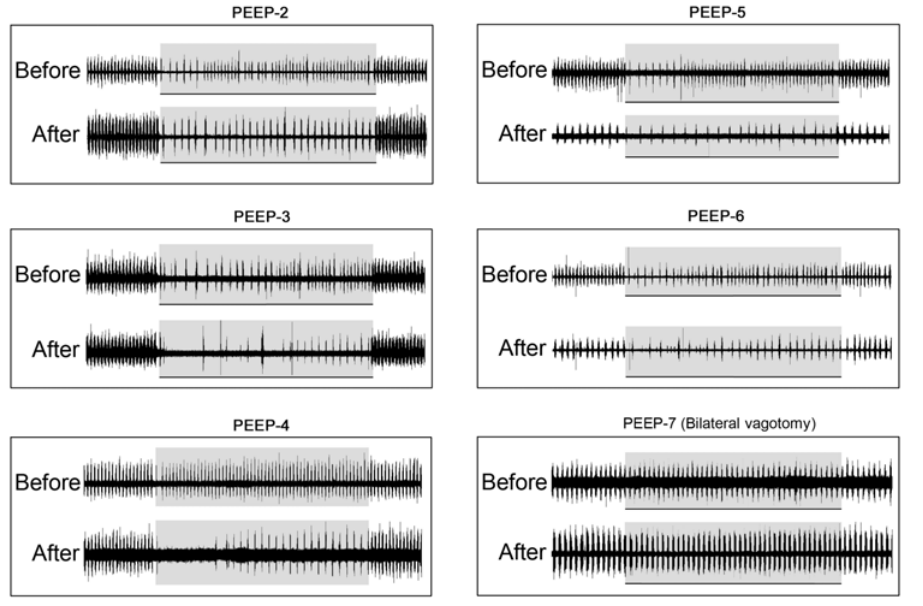
Figure 2. Similar tests as in Fig. 1 (PEEP-1) in five other vagi-intact animals (PEEP-2–PEEP-6) and one vagotomized animal (PEEP-7) before and after bilateral pontine